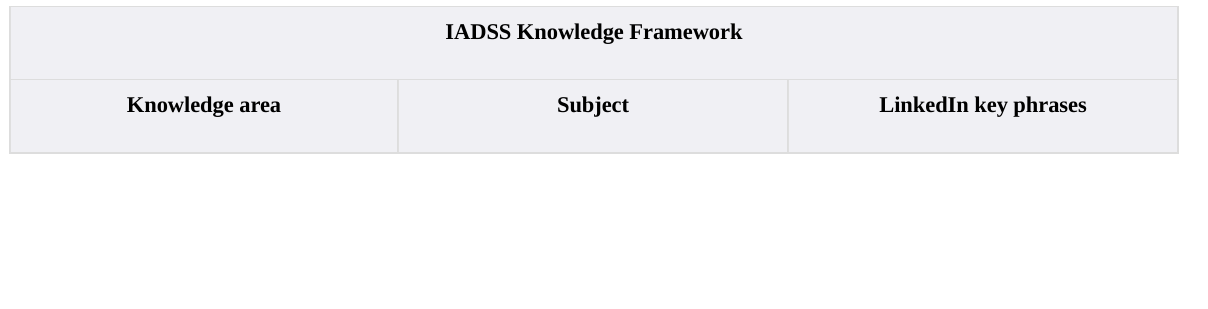
Table 3. Sample key phrases extracted from LinkedIn professional profiles and job postings and the corresponding IADSS Knowledge Framework